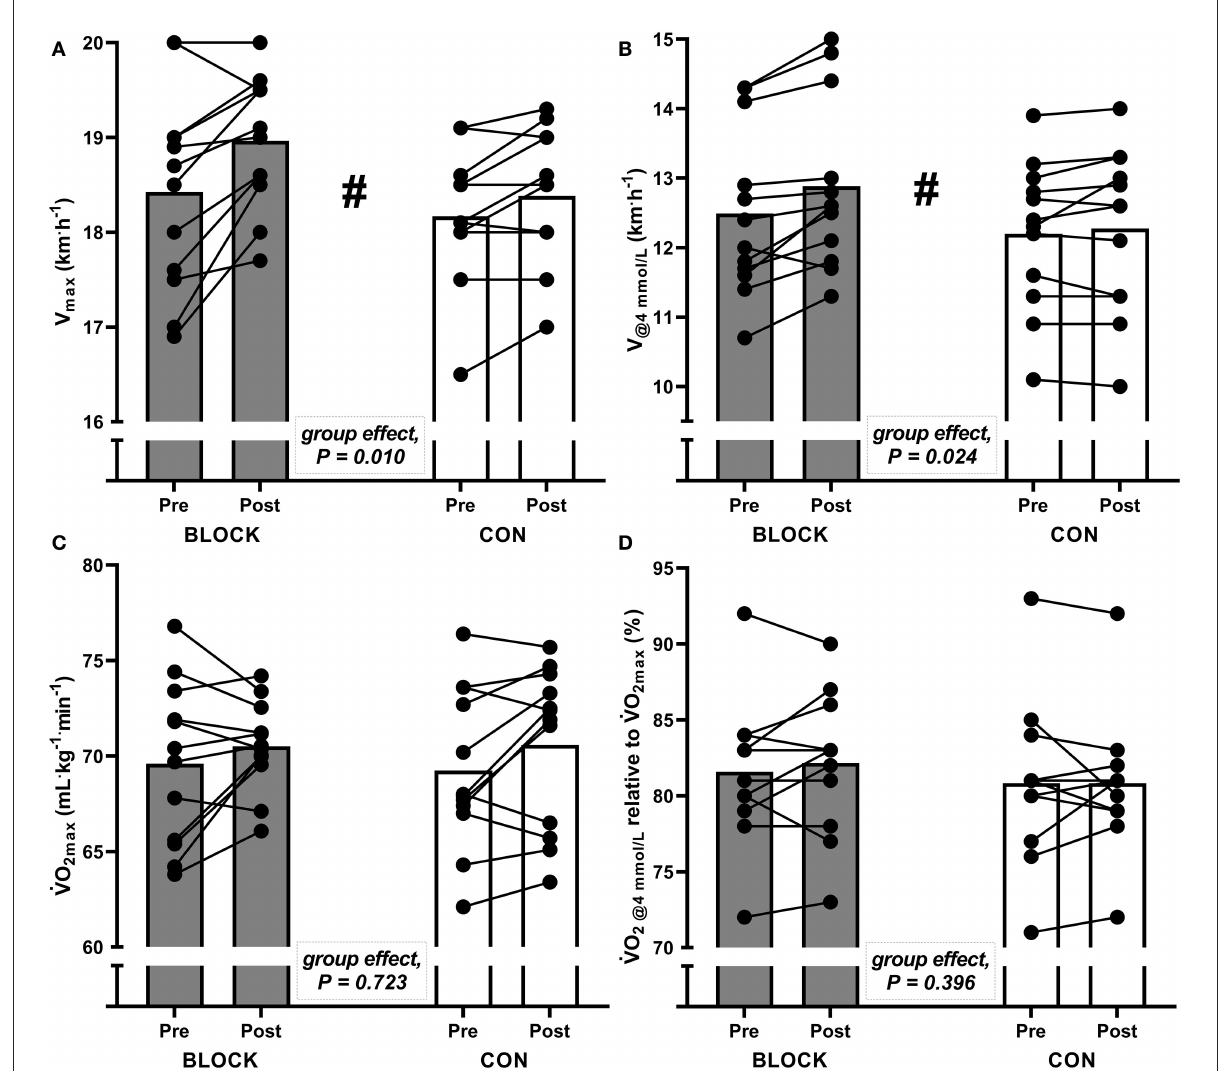
FIGURE2 Individual (dots) and group-average (bars) values for (A) maximal 1-min velocity achieved during the incremental test (V max ), (B) velocity corresponding to 4 mmol . L − 1 blood lactate concentration (V @ 4mmol / L ), (C) maximal oxygen uptake (˙VO 2max ), and (D) fractional utilisation of ˙VO (˙VO 2max at V @ 4mmol / L 2 @ 4mmol / L ) for the HIT block group (BLOCK) and the control group (CON) before (pre) and after (post) the intervention. # Significant different responses between BLOCK and CON.